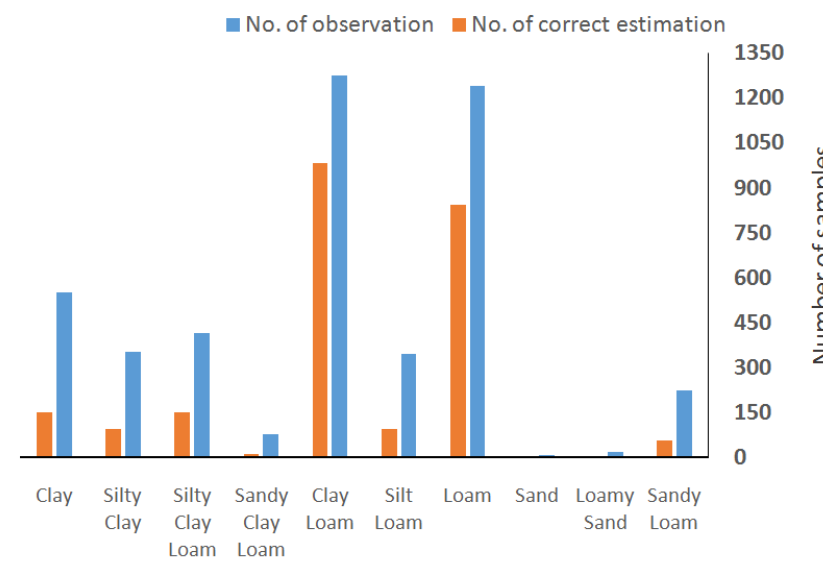
Figure 7. Comparison of the predictability of soil texture classes.